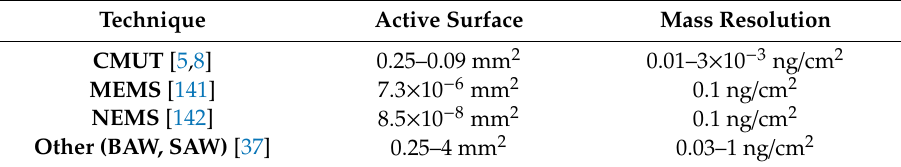
Table 3. Gravimetric detection methods and their parameter